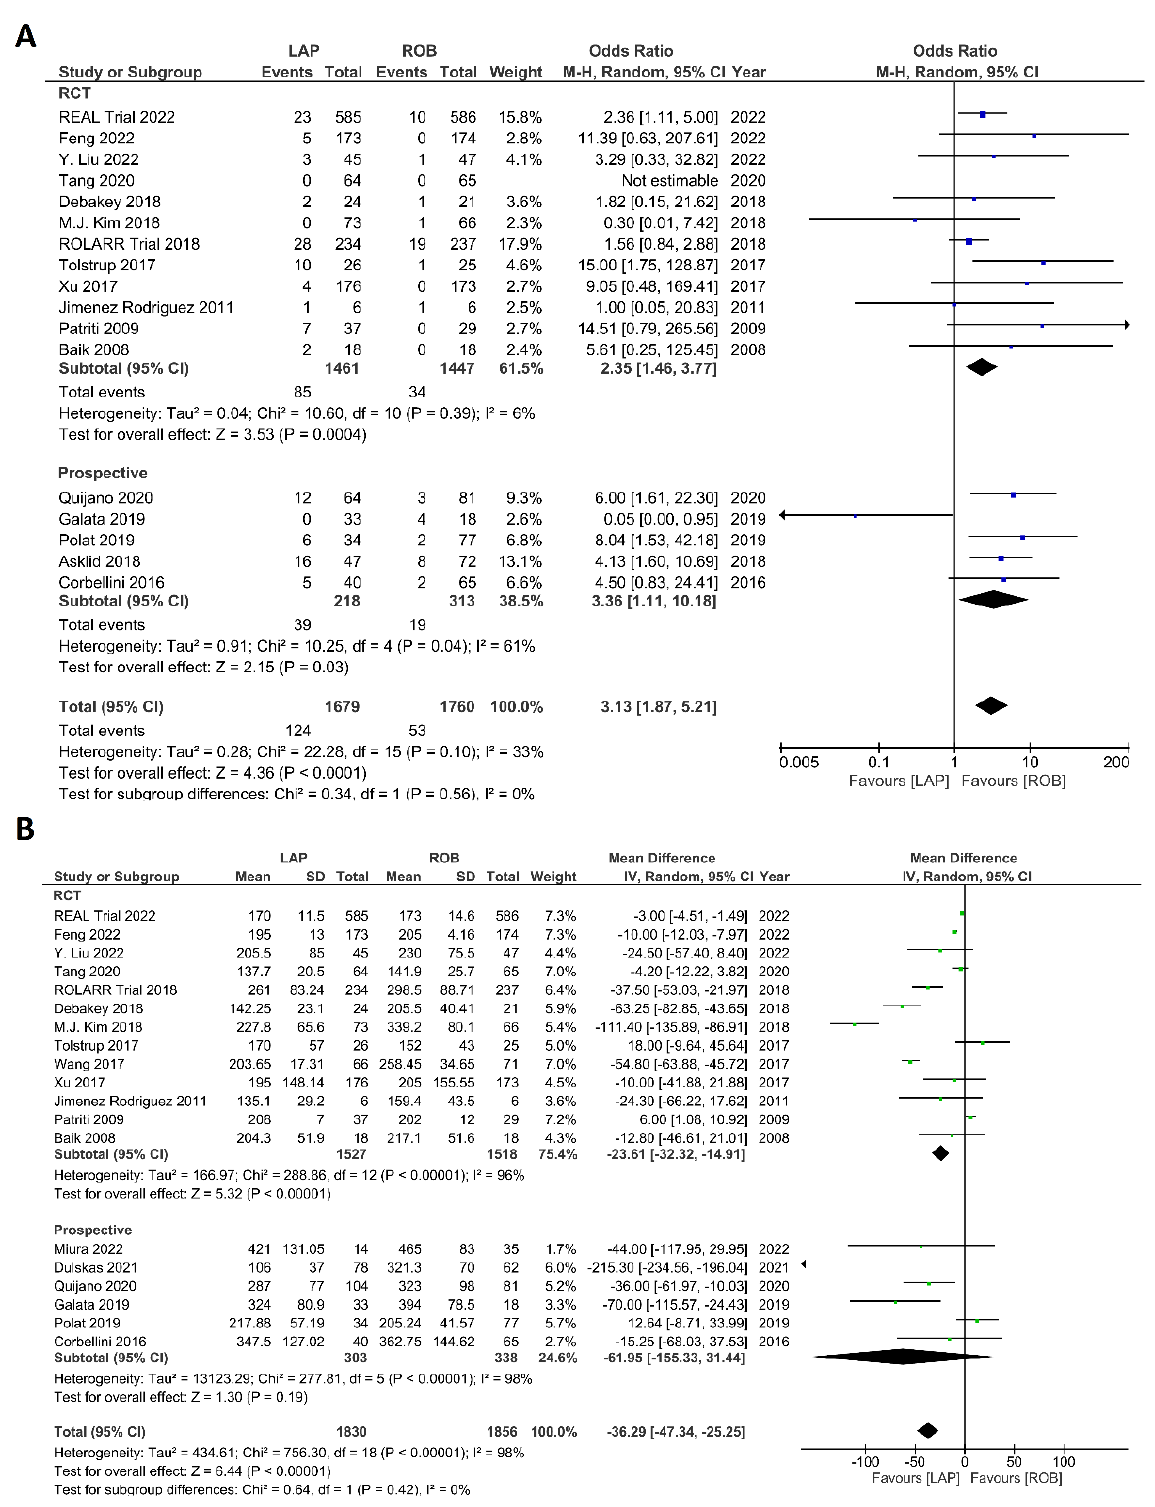
Figure 7. Forest plots comparing ( A ) conversion to open surgery [6,17–19,23,34–38,40–43,45,48,52,53] and ( B ) operation time [6,17–19,23,34–43,47,48,51–53] between robotic and laparoscopic rectal resection (blue boxes representing odd ratios, green boxes representing mean differences, arrows representing 95% confidence intervals, and diamonds representing point estimates of pooled odd ratios or mean differences).